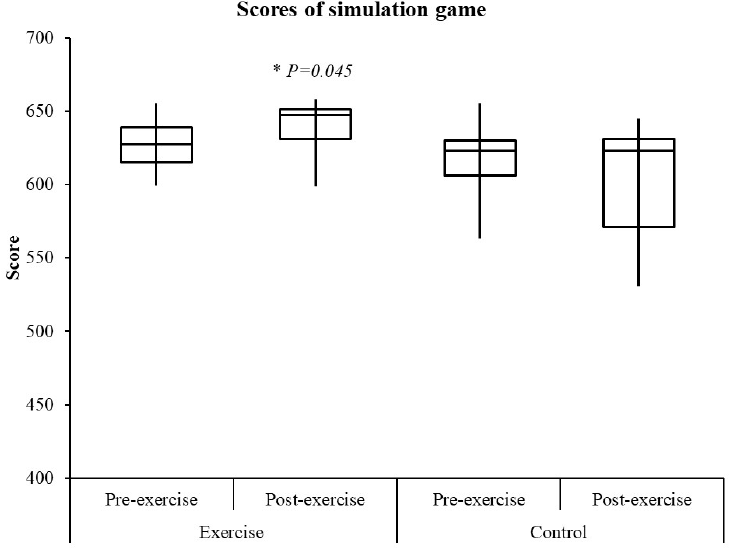
Figure 1. Scores of simulation game. * p ≤ 0.05 between pre- and post-exercise.